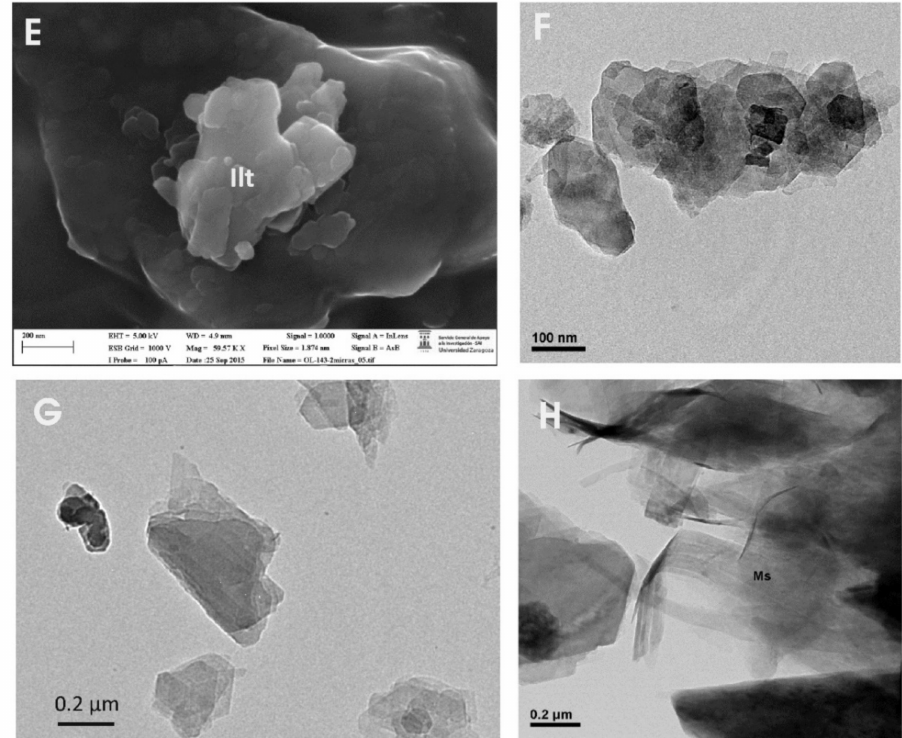
Figure 4. Electron microscopy images showing typical morphologies of kaolinites ( A , C ) and halloysites ( B , D ) and those of illites ( E – H ). ( A , B , E ) are FESEM/SE images; ( C , D , F – H ) are TEM images. Ilt = illite, Ms: